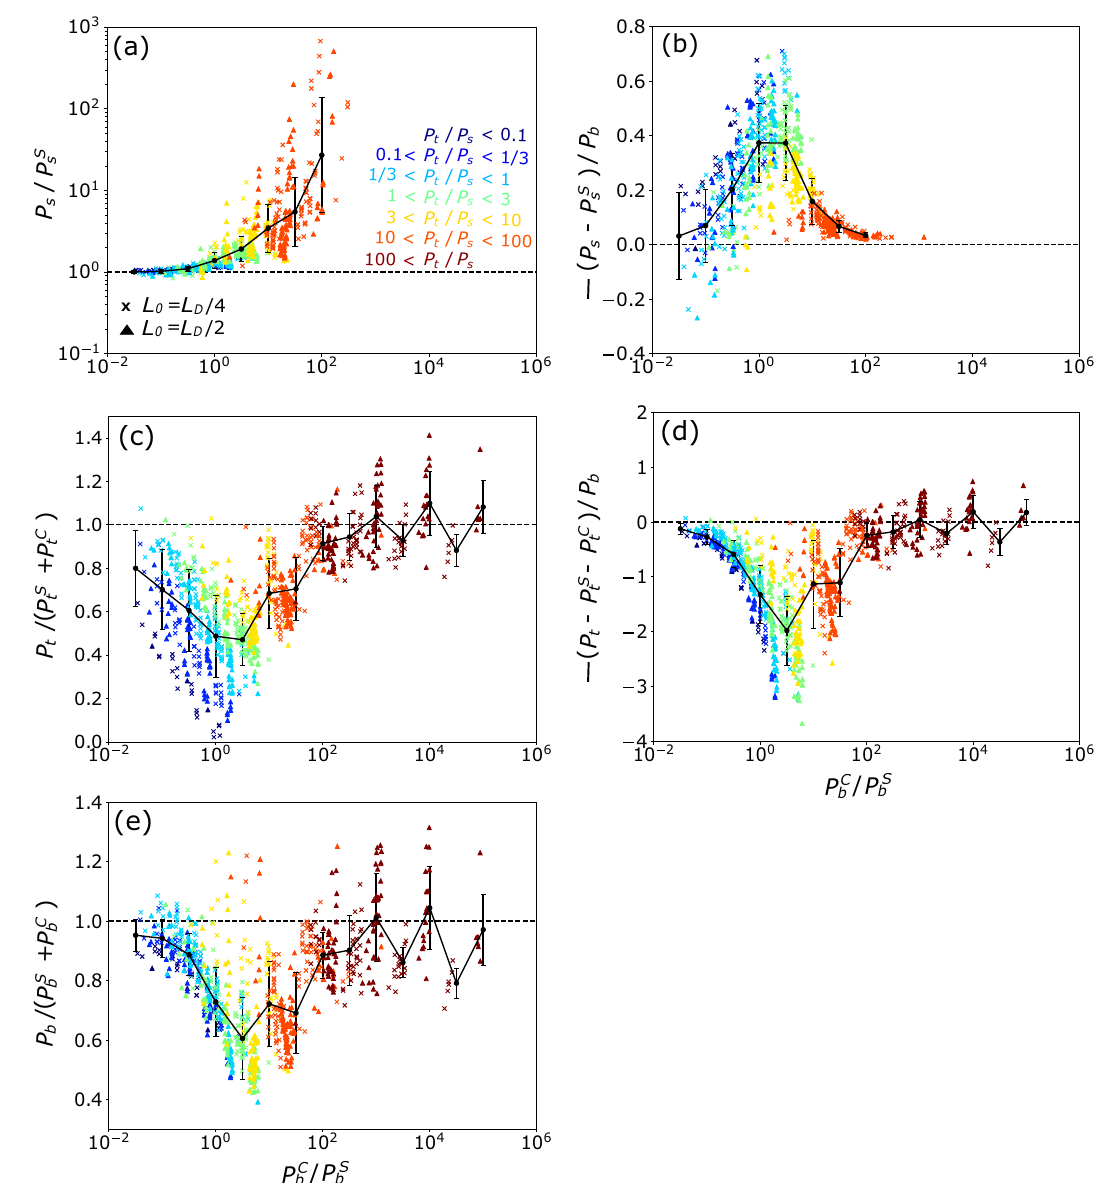
/ P S ) , (d) P C P t /( P S t t + b b and